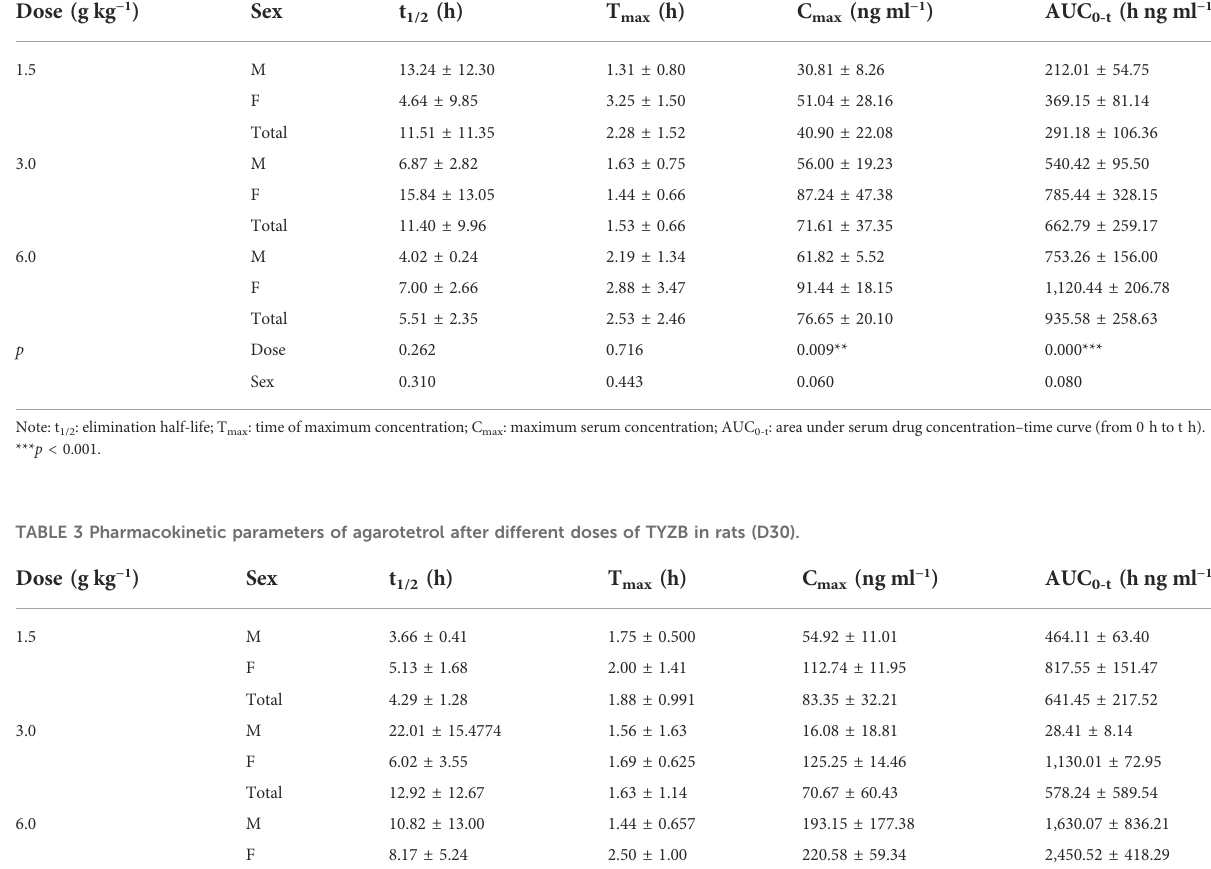
TABLE 2 Pharmacokinetic parameters of agarotetrol after different doses of TYZB in rats (D15). Dose (g kg − 1 )